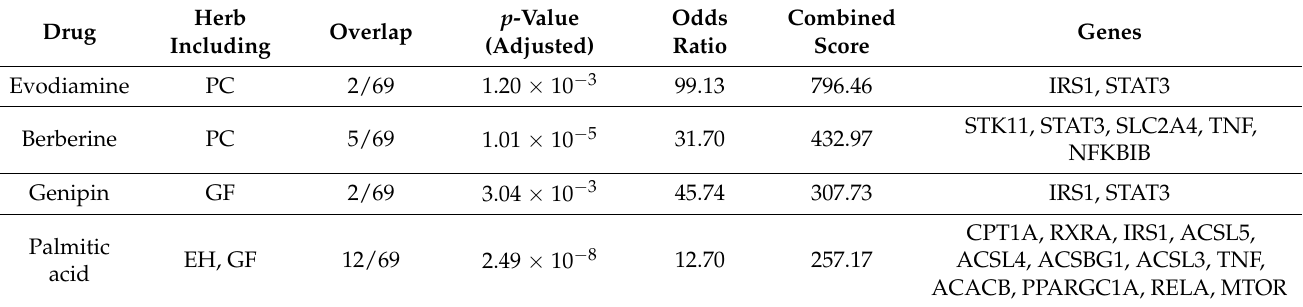
Table 3. GSEA of compounds in AMGB for adipocytokine signaling pathway. TNF: tumor necrosis factor, IRS1: insulin receptor substrate 1, STAT3: signal transducer and activator of transcription 3, STK11: serine/threonine kinase 11,